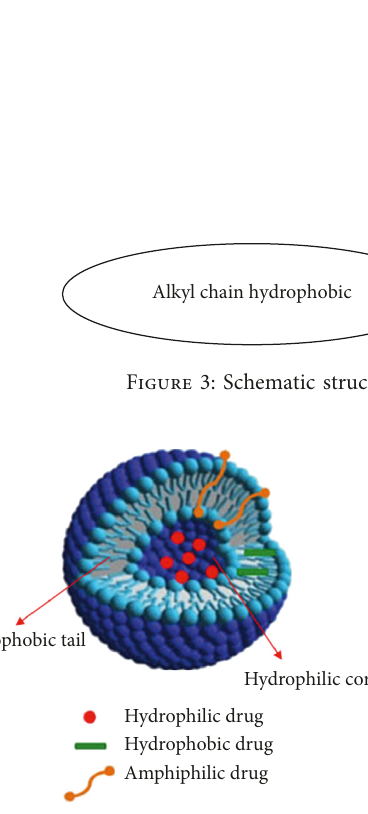
Figure 4: Schematic representation of a niosomes as drug-delivery system